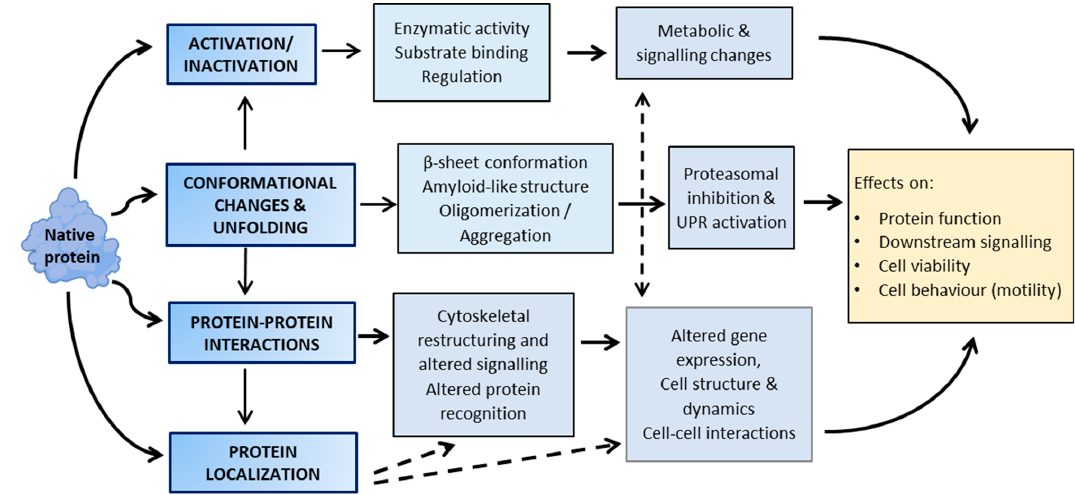
Figure 2. Overview of the biochemical effects of protein lipoxidation, which are highly interrelated.